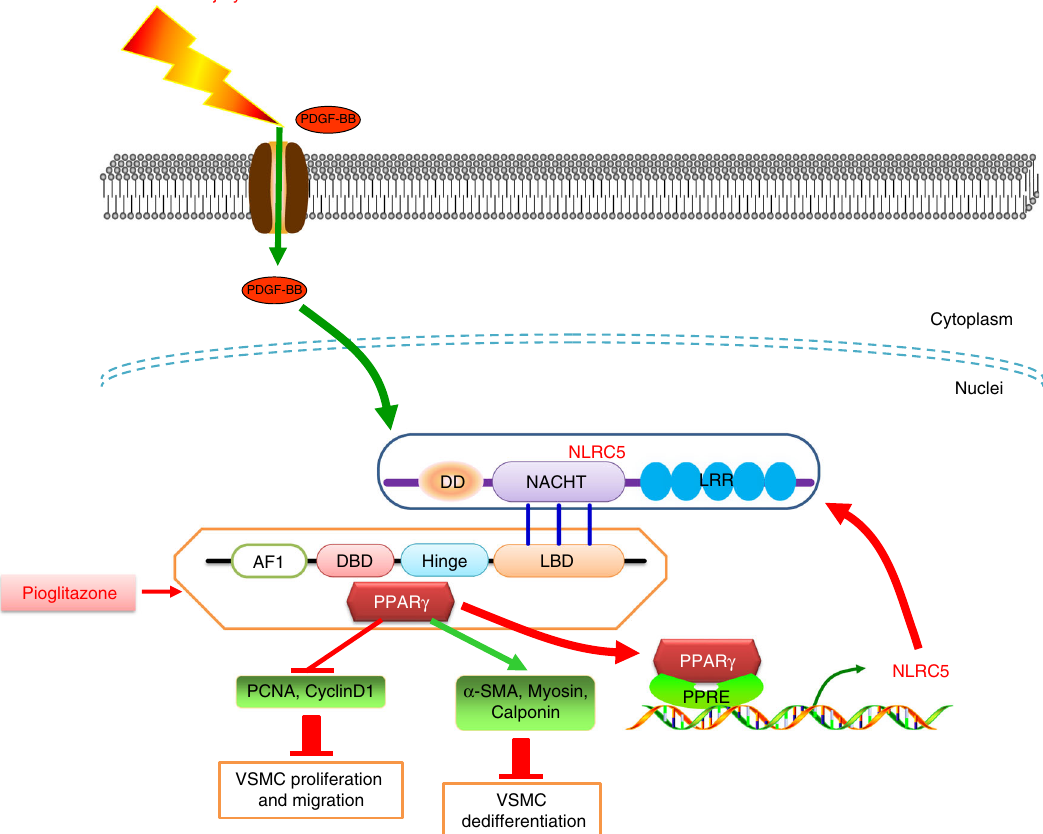
Fig. 8 Proposed model of neointimal formation regulated by NLRC5-PPAR γ feedback Vascular injury releases growth factor PDGF-BB that can activate NLRC5, which predominantly resides in the nuclei of VSMCs. NACHT domain of NLRC5 binds to ligand-binding domain (LBD) of PPAR γ and facilitates PPAR γ activity. PPAR γ is in turn recruited at the promoter of NLRC5 and drives NLRC5 transcription. NLRC5-PPAR γ positive feedback subsequently regulates downstream gene expression including PCNA, Cyclin D1, α -SMA, Myosin, and Calponin, and eventually suppresses VSMC proliferation, migration, and dedifferentiation and retards neointimal